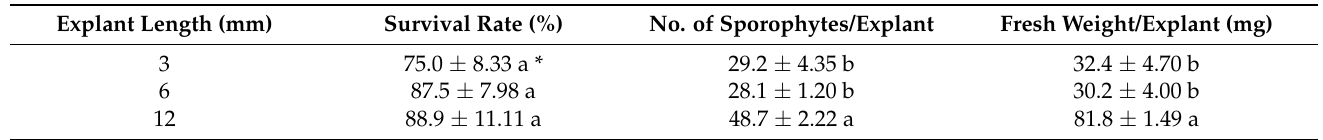
Table 2. Effect of explant growth on S. tamariscina (P.Beauv.) Spring growth and sporophyte regeneration after 12 weeks of culturing on 1/4 MS medium.